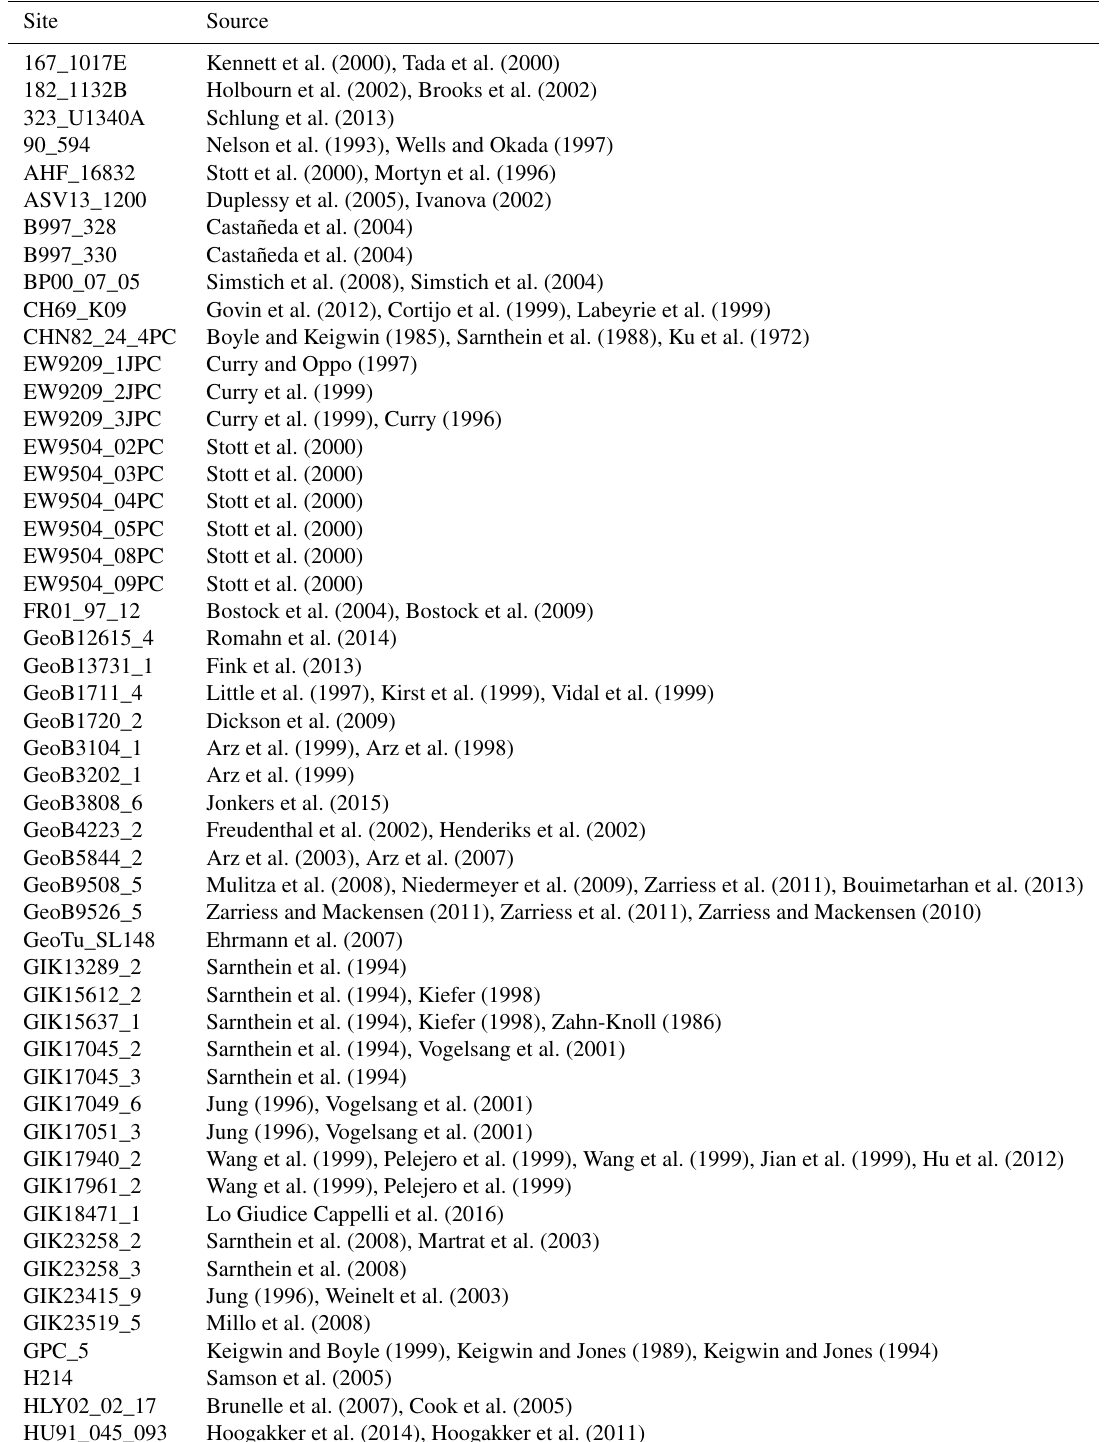
Table A1. Data sources for version 1.0.0 of the PalMod 130k marine palaeoclimate data synthesis. An extended version of this table can be accessed at https://doi.org/10.5281/zenodo.3739019 (Jonkers et al.,